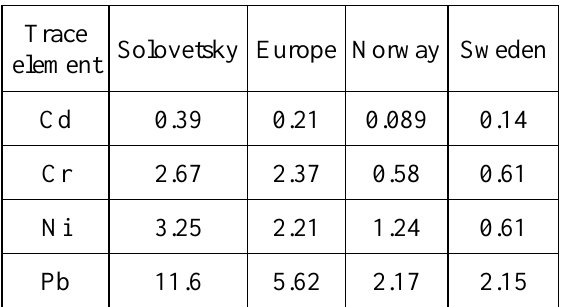
Table 6. Trace element concentrations (ppm) in moss tissue. The data for Solovetsky are median values for moss peat (only), obtained in this study. Mean values for Europe, Norway and Sweden in 2005, after Harmens et al. (2010, 2013), are shown for